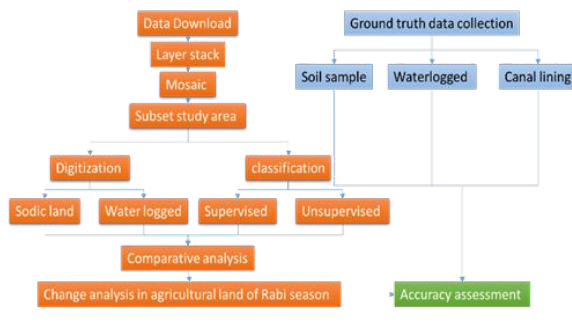
Figure 5: Methodology flow chart